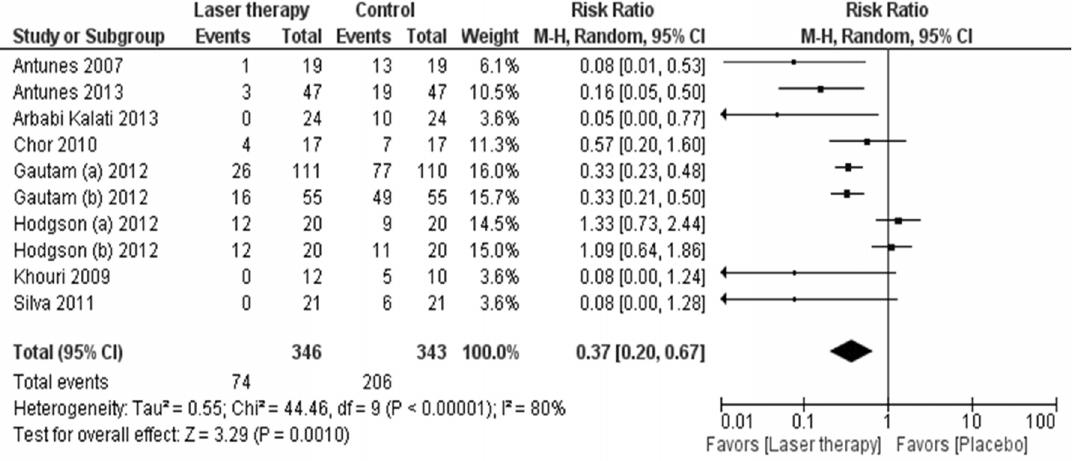
Figure 2. Forest plot of overall incidence of severe (grade 3 or 4) mucositis. Squares to the left of the vertical line indicate that low level laser therapy reduces mucositis. Horizontal lines through the squares represent 95% confidence intervals (CIs). The size of the squares reflects each study’s relative weight, and the diamond represents the aggregate risk ratio and 95% CI.